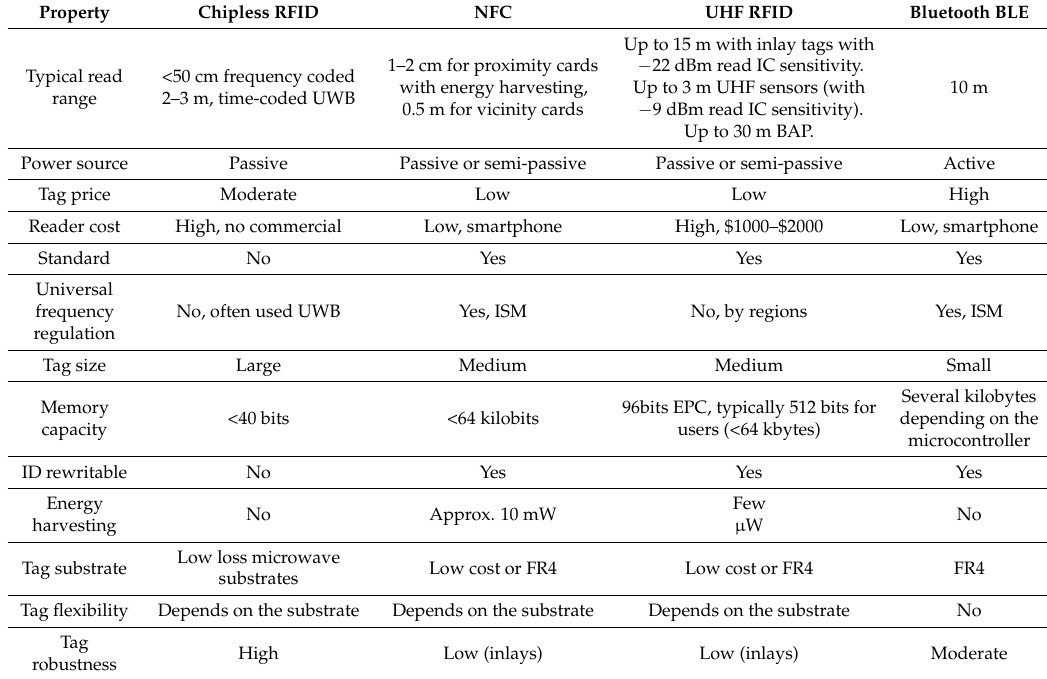
Table 1. Comparison of radio-frequency identification (RFID) sensor technologies.